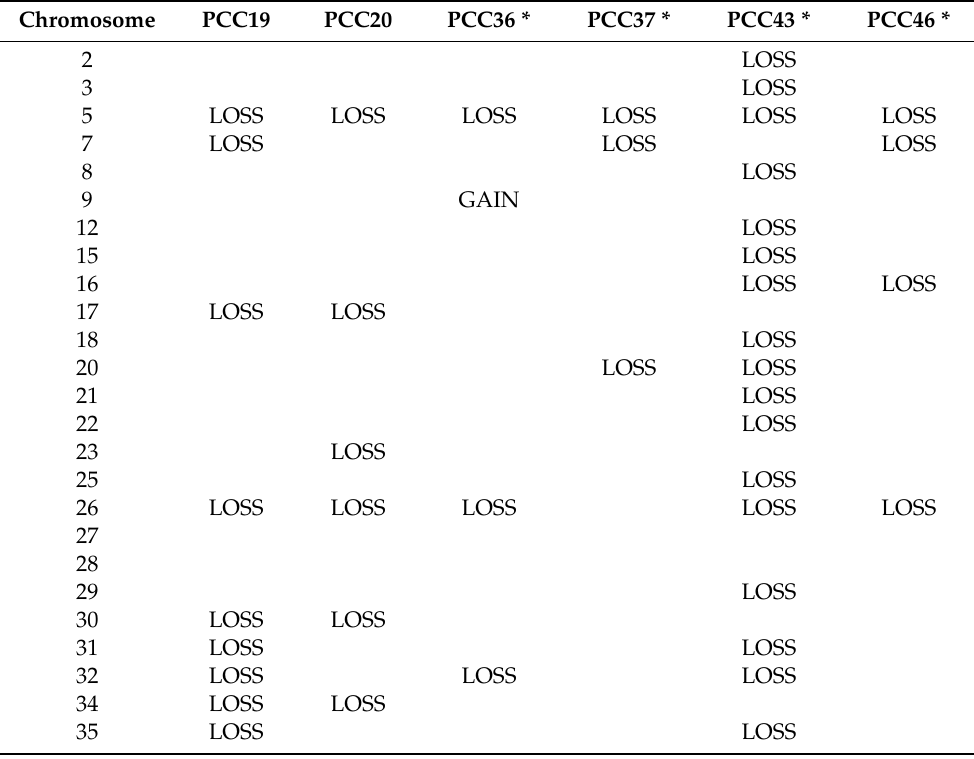
Table 2. Summary of single nucleotide polymorphism (SNP) array